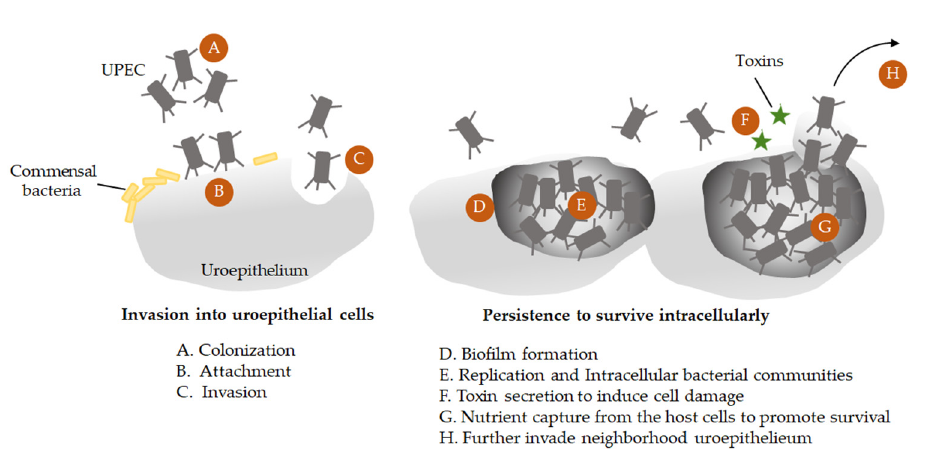
Figure 1. The invasive process of uropathogenic Escherichia coli into the uroepithelium. After the colonization of uropathogens, the preliminary step of UTI relies on adhesins, especially type I fimbriae, which enable uropathogens to recognize specific extracellu- lar matrix proteins (laminin, fibronectin, collagen, and Tamm–Horsfall proteins) on the bladder epithelium, thereby binding to uroepithelial cells [27,28]. Furthermore, P fim- briae related to the process of invasion mediate other mannose-resistant adhesins. At this mo- ment, some uropathogens are initially cleared by the fi rst wave of host in fl ammatory re- sponses, while others avoid the host’s defenses by intracellular invasion or morphological changes that are resistant to neutrophils. After intracellular invasion, they reside within vesicles by forming bio fi lms and undergo rapid and massive replication to establish intra- cellular bacterial communities within the cytosol of urothelial cells [22,41,42]. In addition, bio fi lms, which manifest as the presence of an extracellular matrix capable of containing